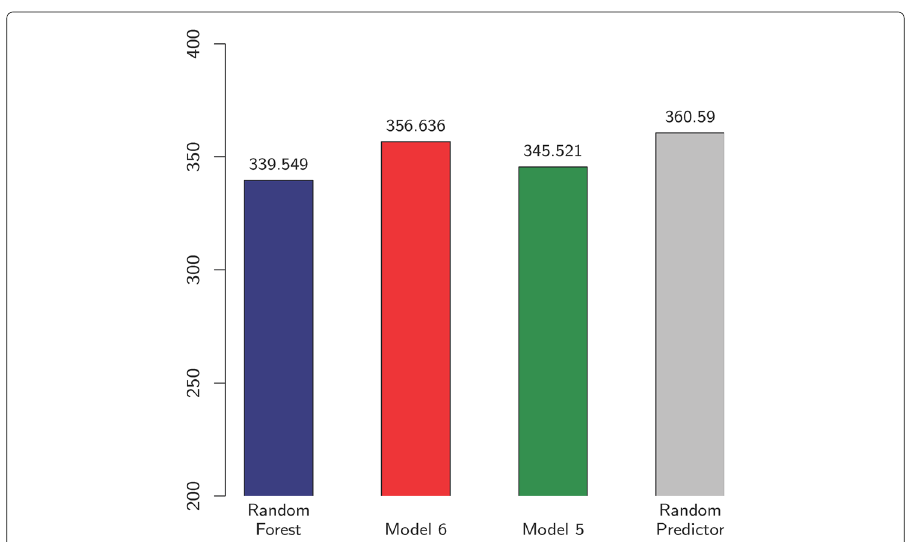
Fig. 3 Mean Absolute Percentage Error